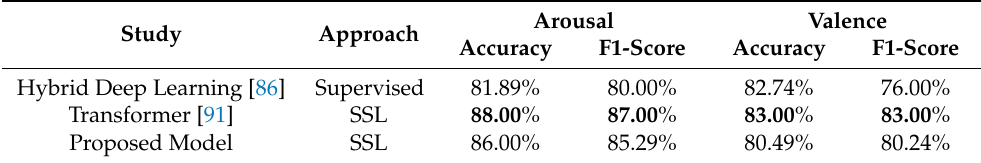
Table 7. Classification results reported by various state-of-the-art works on the AMIGOS dataset.